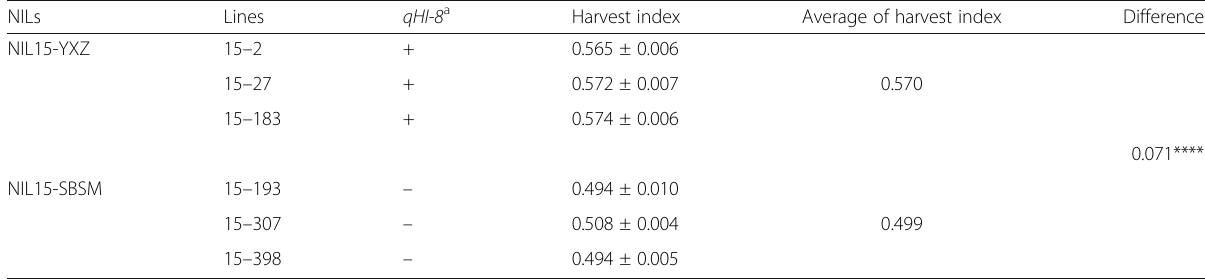
Table 3 Estimation of the relative effect of qHI-8 on harvest index using two sets of contrasting NILs NILs Lines qHI-8